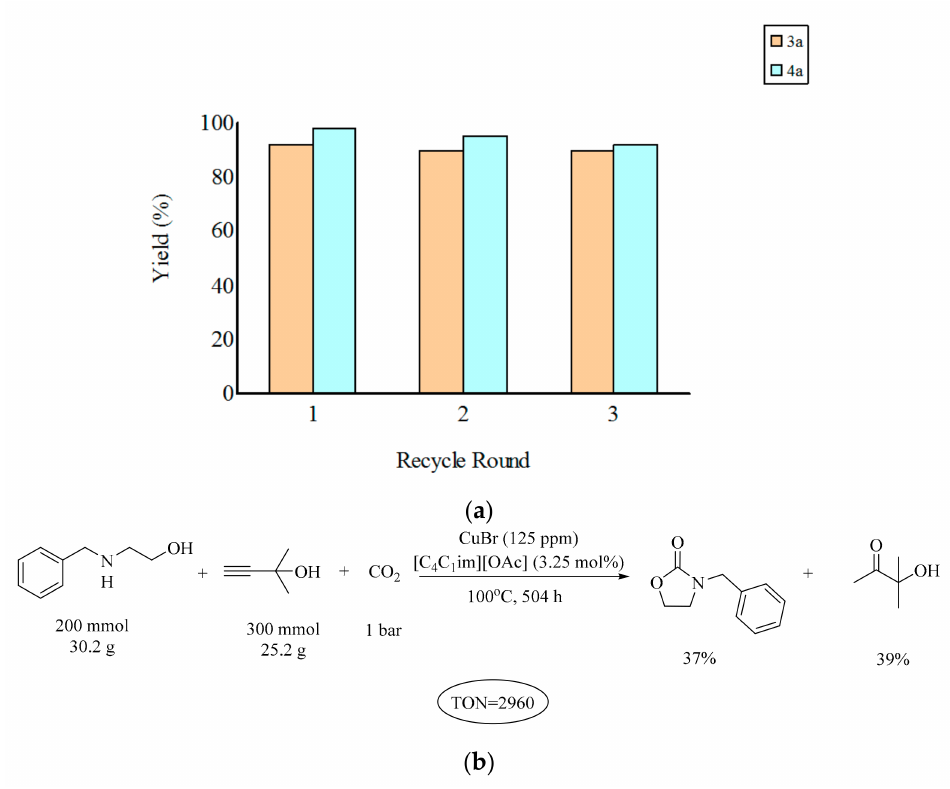
Figure 1. ( a ) Recyclability of the CuBr/[C 4 C 1 im][OAc] system; ( b ) evaluation of turnover number (TON) for the CuBr/[C 4 C 1 im][OAc]